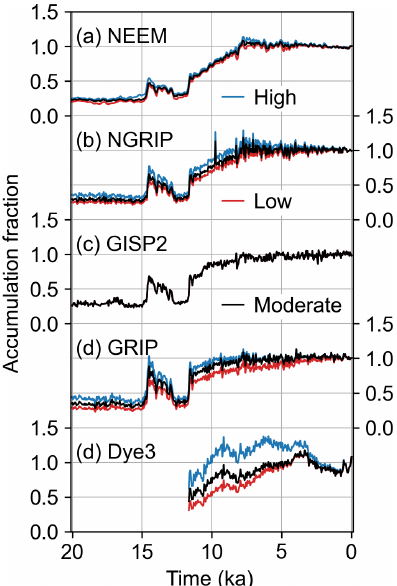
Figure 3. Accumulation records assimilated to reconstruct precipi- tation for the main reanalysis and two sensitivity scenarios. Records are shown as fractions relative to the mean during 1850–2000 CE and are ordered top to bottom from northernmost to southernmost. Black lines are the moderate records which are included in the main precipitation reanalysis, red lines are the low records which are in- cluded in the low-sensitivity scenario, and blue lines are the high records which are included in the high-sensitivity scenario. Note that we use the same GISP2 accumulation record for the main, high, and low scenarios. Ice-core site names are given above each set of